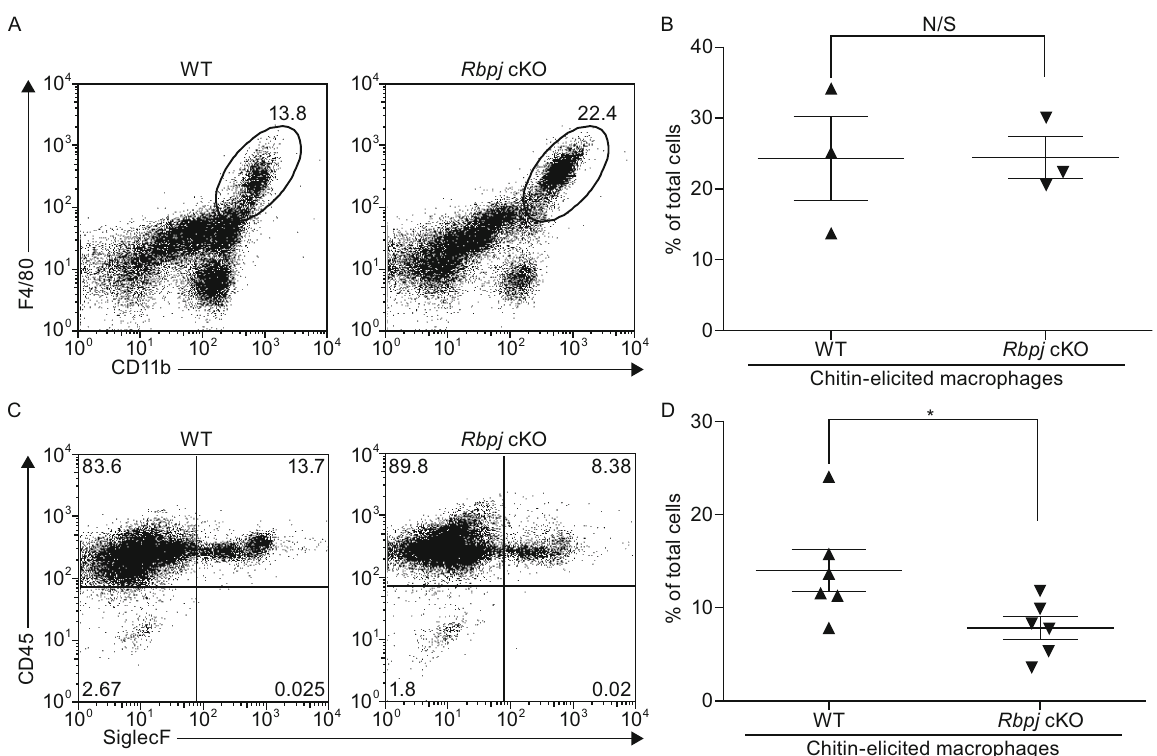
Figure 1. A role for Rbpj in eosinophil recruitment in response to chitin administration. (A) Expression of CD11b and F4/80 in peritoneal exudates cells (PECs) harvested from WTand Rbpj cKO mice 1 d after peritoneal injection with chitin. Circles and numbers indicate percentage of macrophages (CD11b + F4/80 + ) in total PECs. Results from one representative experiment are shown. (B) Cumulative data showing percentage of macrophages as in (A) from three independent experiments. (C) Expression of CD45 and SiglecF in PECs harvested from WT and Rbpj cKO mice 1 d after peritoneal injection with chitin. Quadrants and numbers indicate percentage of eosinophils (CD45 + SiglecF + ) in total PECs. (D) Cumulative data showing percentage of eosinophils as in (C) using six pairs of littermate mice with desired genotypes. Errors bars indicate s.d. * P < 0.05 (two-tailed Student ’ s